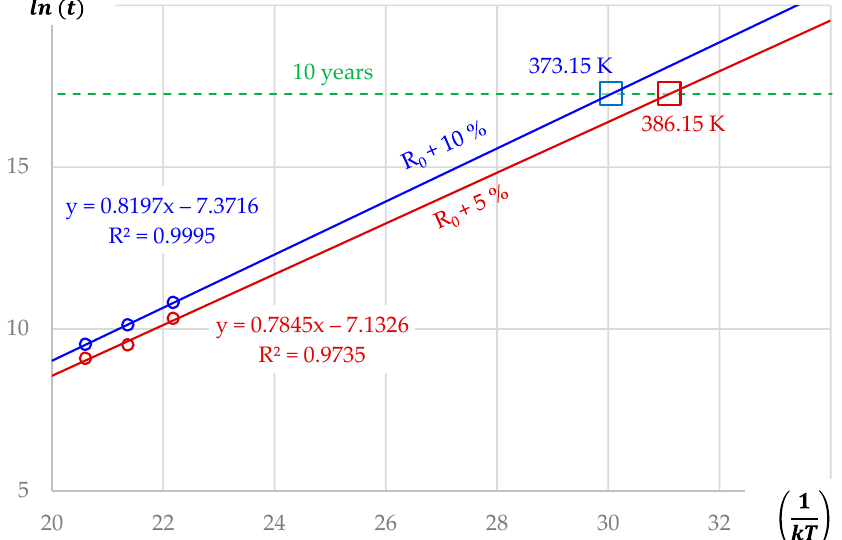
Figure 6. Estimation of temperature conditions that allow 10-year retention of LRS.